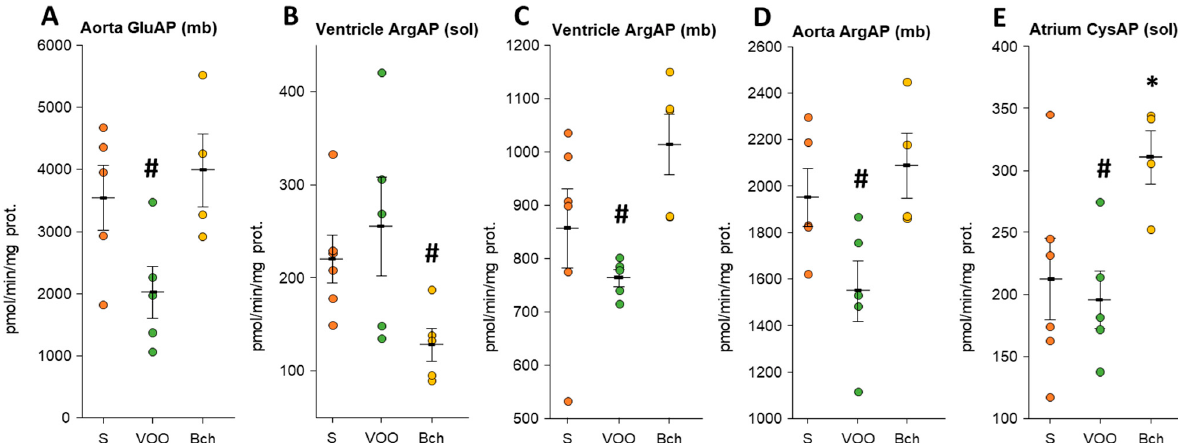
Figure 2. Mean values ± standard errors of significant ( A ) glutamyl aminopeptidase (GluAP), ( B – D ) arginyl aminopeptidase (ArgAP), ( E ) cystinyl aminopeptidase (CysAP) activities in soluble (sol) and membrane-bound (mb) fractions of atrium, ventricle, and aorta. The small colored dots are data points per group. Values are expressed as pmol/min/mg prot in the rest of the tissues analyzed. * indicates significant differences between virgin olive oil diet (VOO) or butter plus cholesterol diet (Bch) vs. standard diet (S). * p < 0.05. # indicates significant differences between VOO and Bch, # p < 0.05.